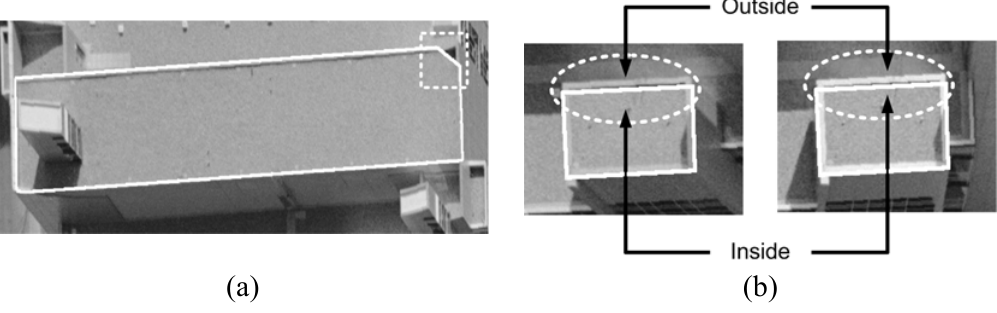
Figure 12. Erroneous boundary segments produced through the refinement process due